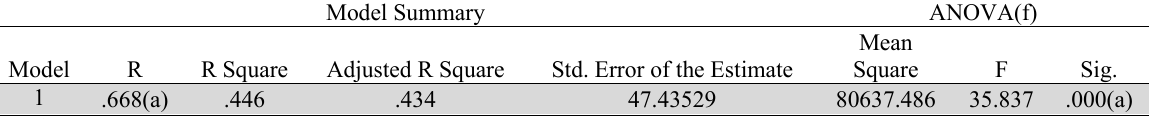
The Relationship between Constraint Management and Value Chain Performance